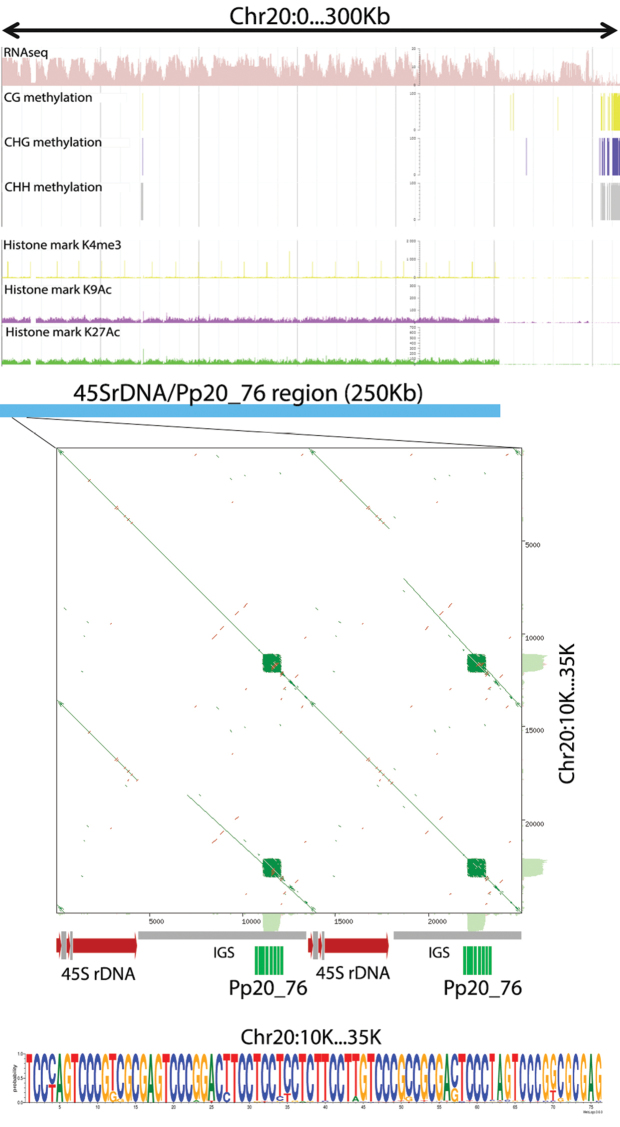
Genomic organization and epigenetic landscape of 45SrDNA/PpNATR76 locus. Top panel is a snapshot of CoGe GBrowser for P.patens (https://genomevolution.org/) . Logo picture from multiple alignment of 200 PpNATR76 monomers is shown at the bottom.